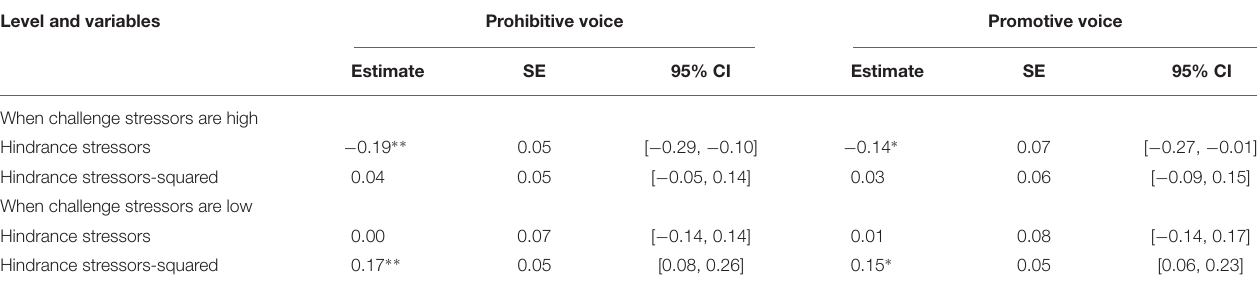
TABLE 5 | The effect of job stressors on prohibitive and promotive voice. Level and variables